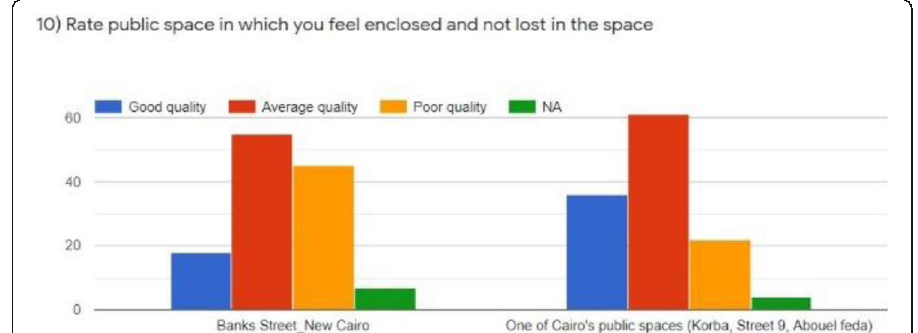
Fig. 24 Enjoying place aesthetics in public spaces (Author)